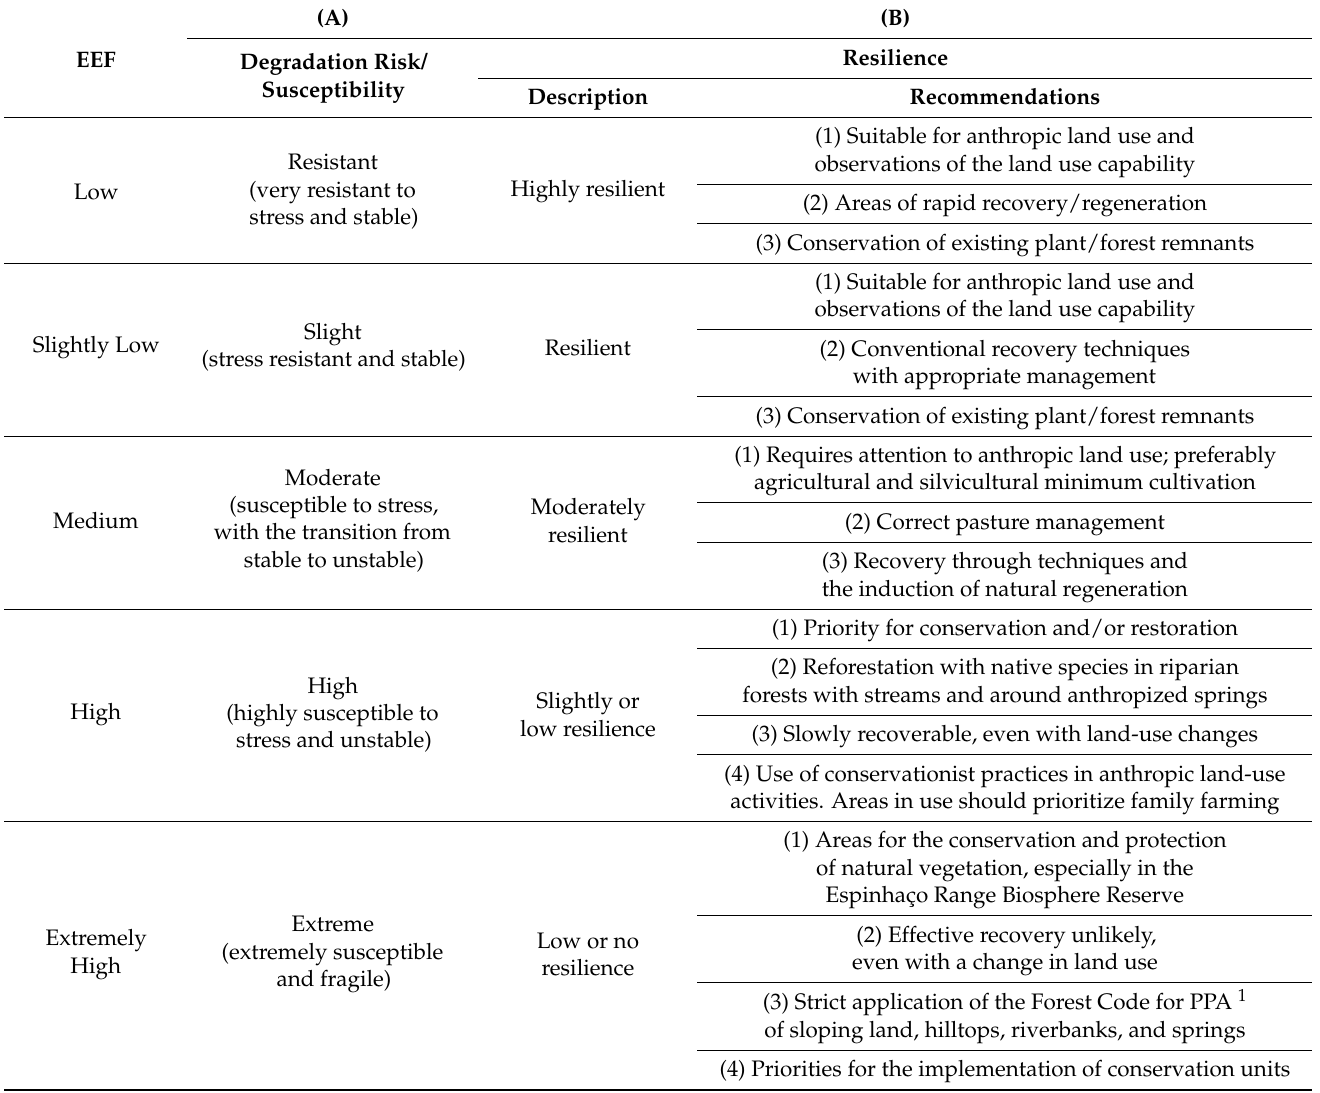
Table 8. Emerging environmental fragility classes; degradation risk and susceptibility scenarios; recommendations/proposals for conservation, recovery, and sustainable land